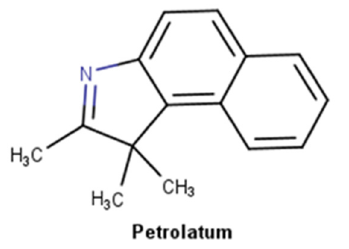
Figure 10. Chemical structure of petrolatum.